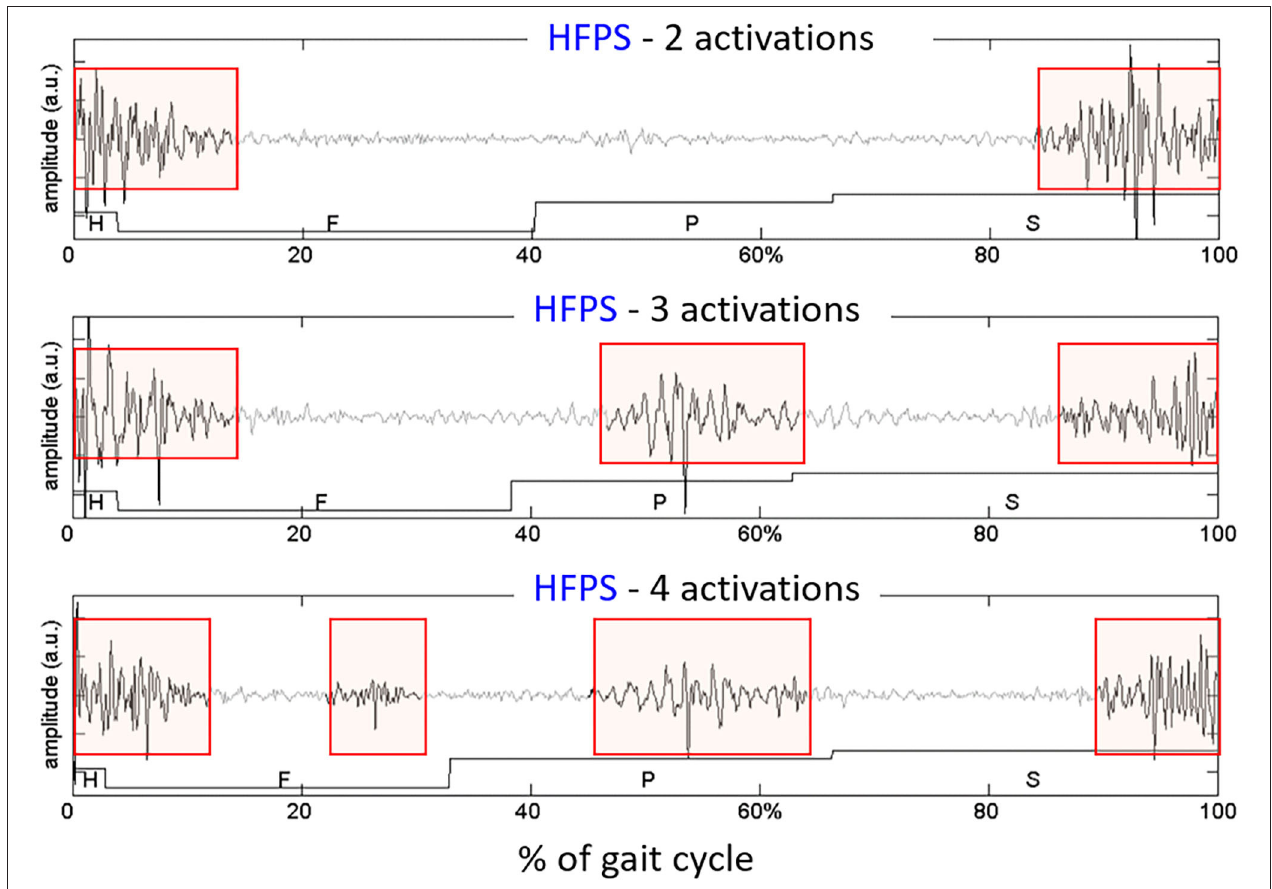
FIGURE 6 | Example of different activation modalities of the Rectus Femoris, observed in sEMG signals collected from an healthy subject, on 3 gait cycles of the same type (HFPS) collected during the same walk. The colored boxes highlight the intervals in which the muscle activity is present.